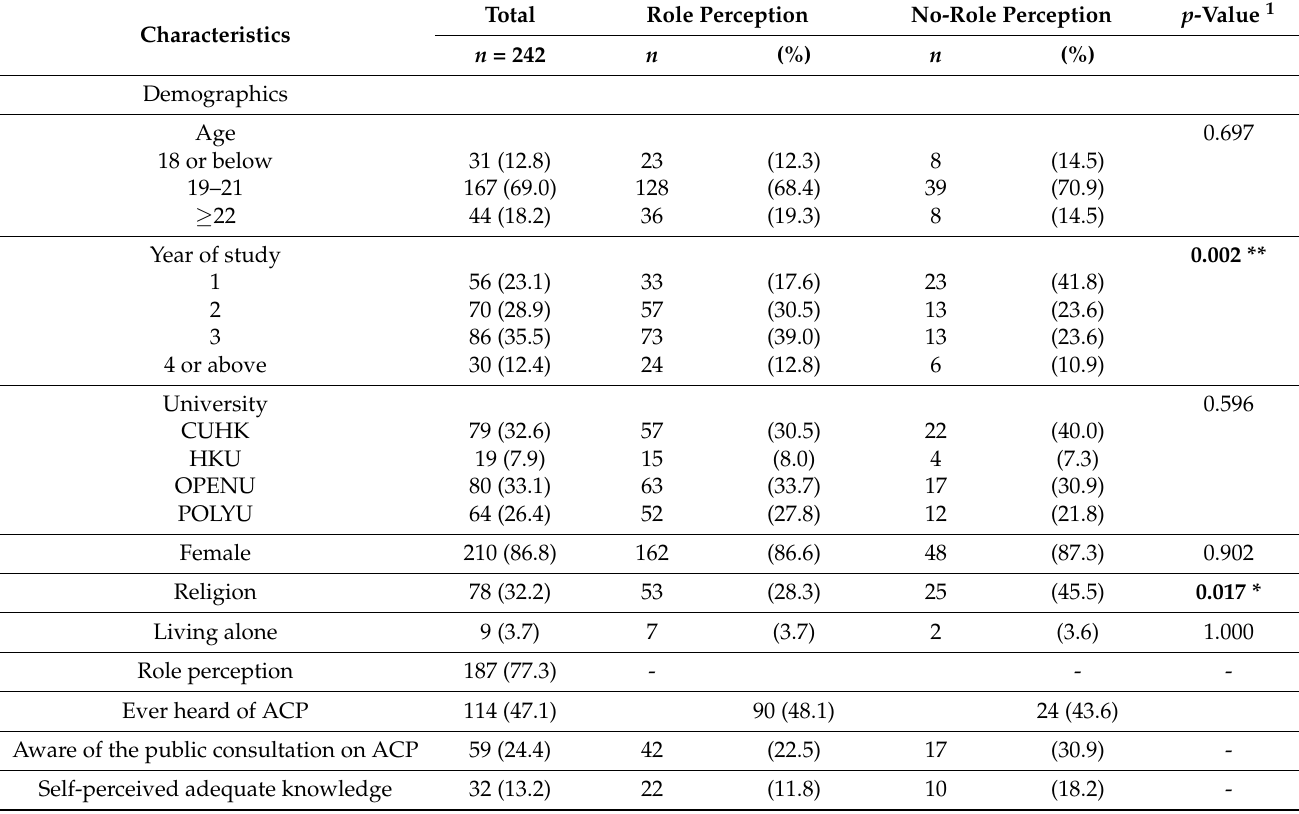
Table 1. Demographics of the Hong Kong nursing undergraduates assessed in this study.